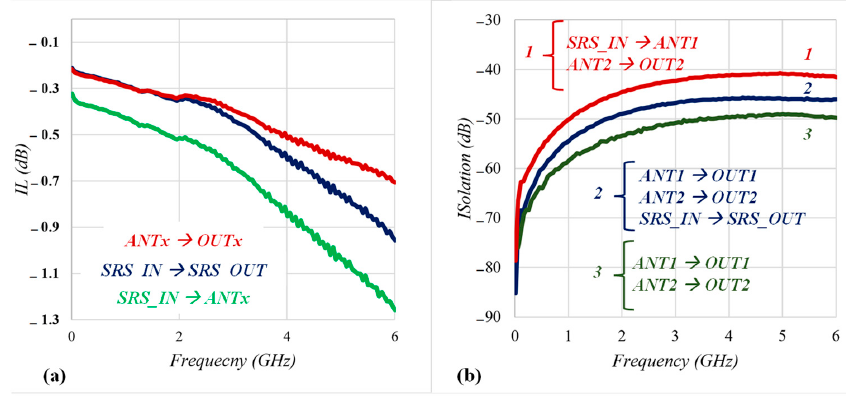
Figure 5. Measured result of the ( a ) IL and ( b ) isolation of the proposed 3P3T.